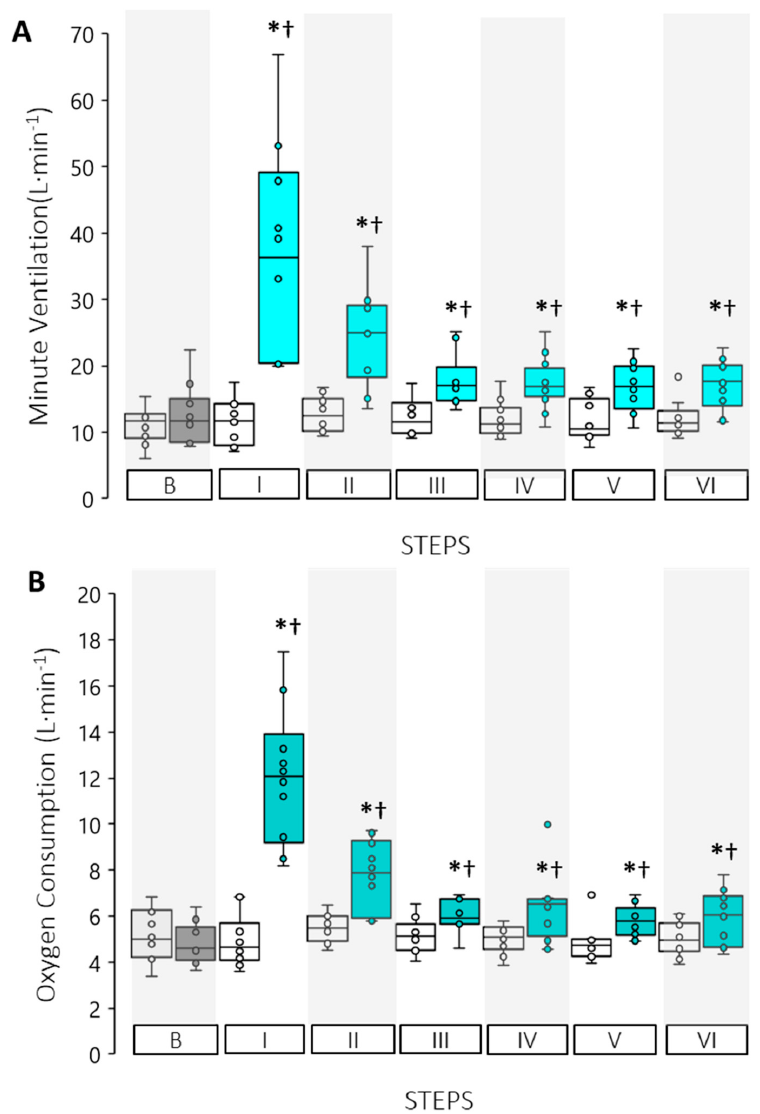
Figure 4. Respiratory results for control (open boxes) and experimental trials (shaded boxes) for ( A ) minute ventilation 𝑉 ˙ E , and ( B ) oxygen consumption 𝑉 ˙ O 2 . (*) Indicates a significant difference between trials for that Step, (†) Indicates a signi fi cant time main-effect difference from Baseline ( p < 0.05).